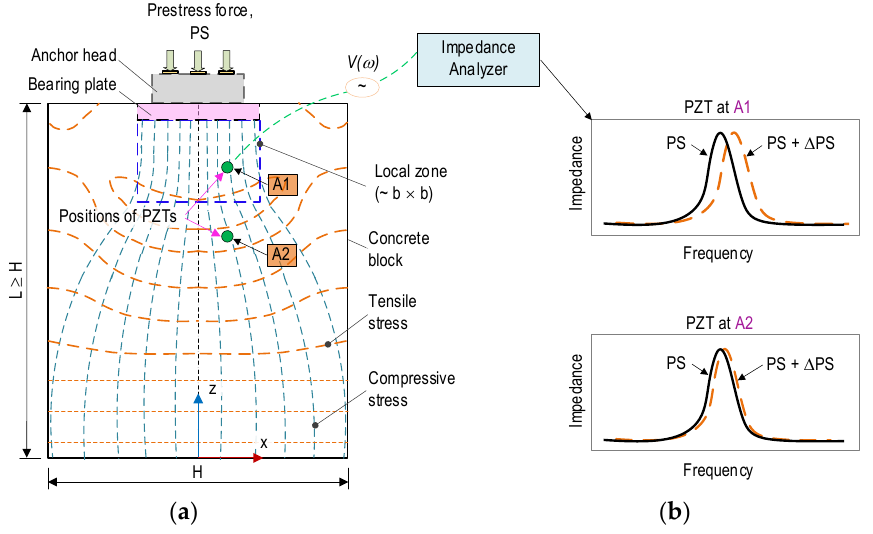
Figure 5. Concept of impedance-based damage monitoring in PSC anchorage via embedded PZT sensor: ( a ) PSC anchorage installed with PZT sensors; ( b ) Impedance responses obtained from PZTs.